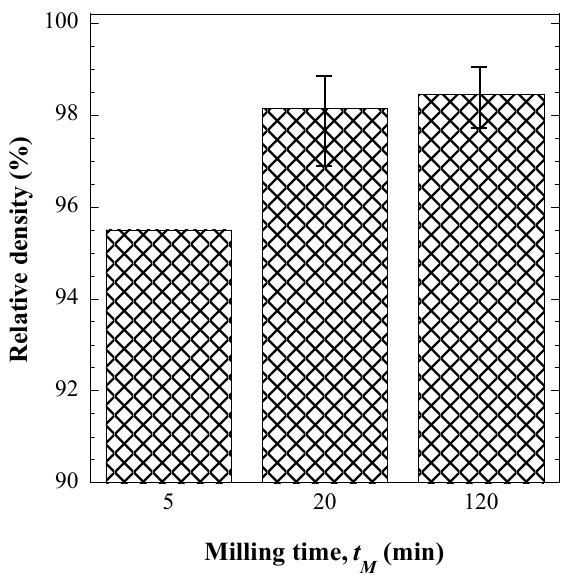
Figure 3. Effect of milling time on the relative density of ZrC samples obtained by SPS ( T D = 1850 °C, t D = 10 min, p = 50 MPa).